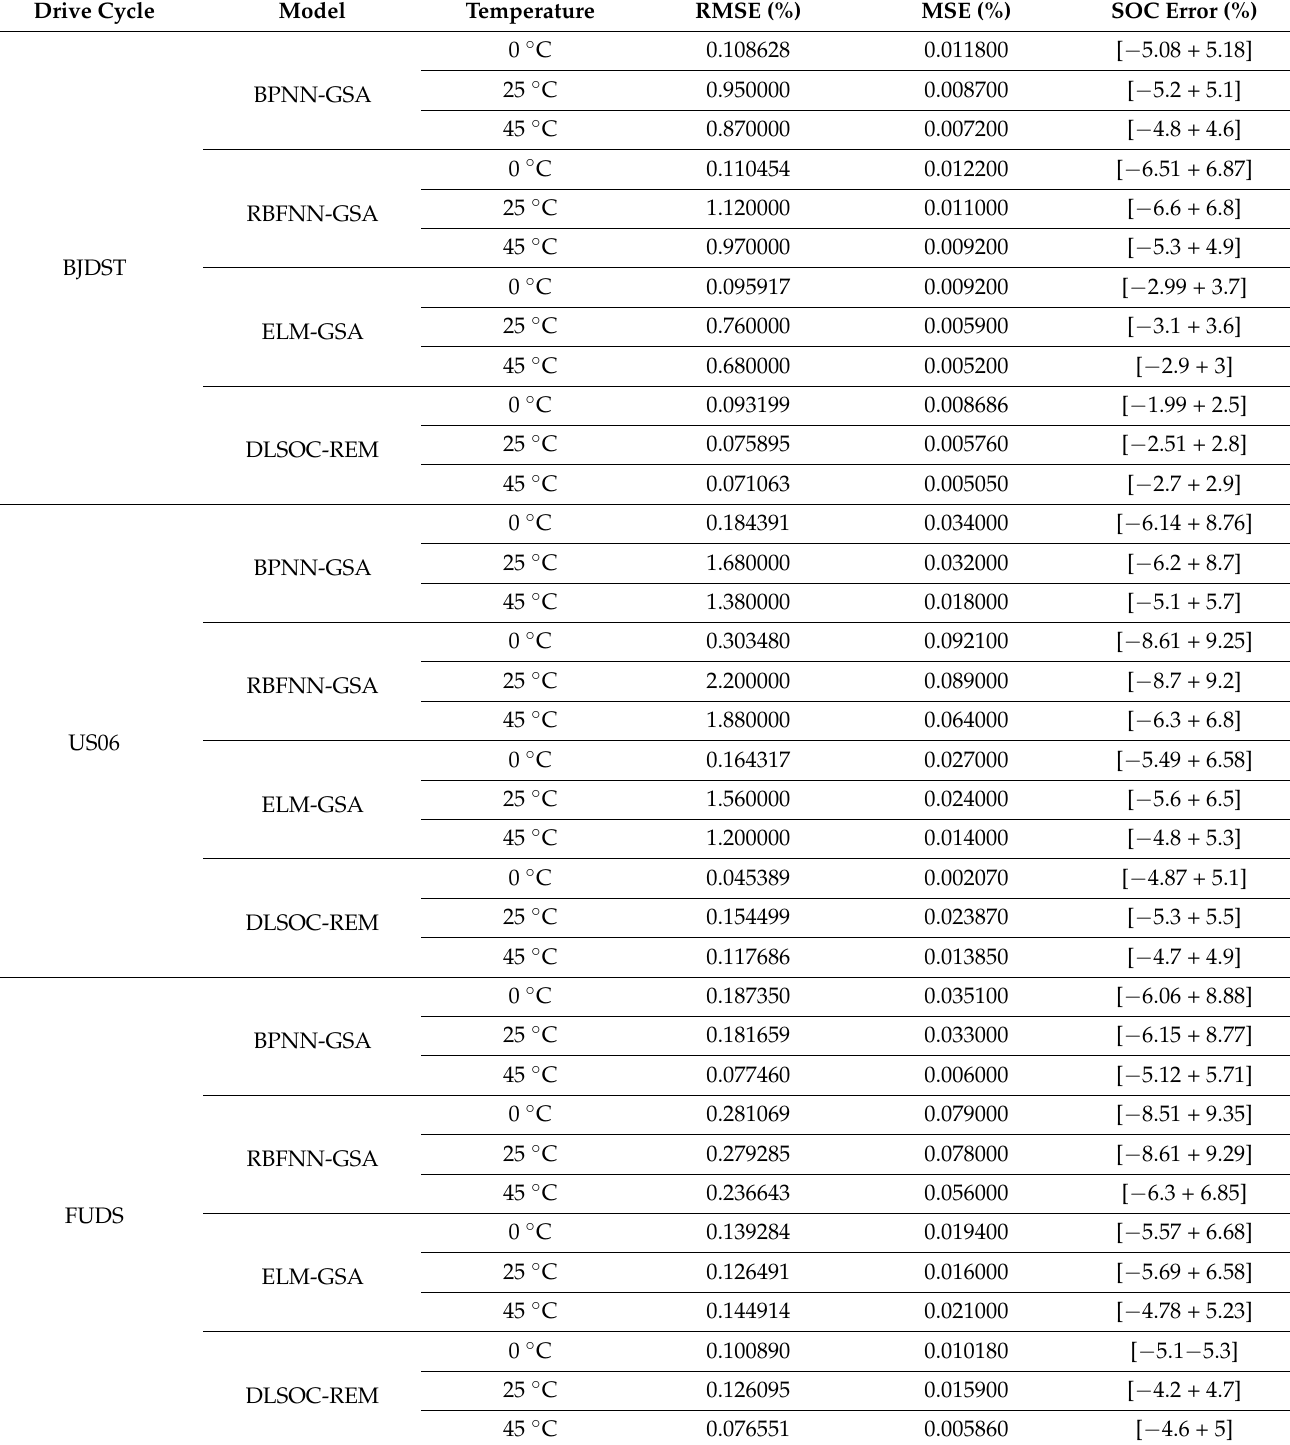
Table 2. Comparative result analysis of DLSOC-REM technique with recent approaches under different drive